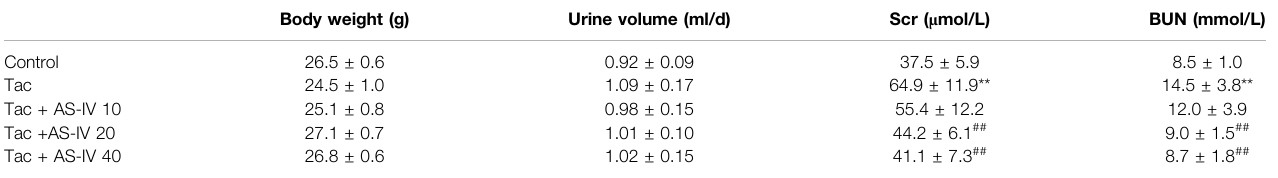
TABLE 1 | Effect of Astragaloside IV on tacrolimus-induced chronic nephrotoxicity in mice ( n (cid:1) 8).